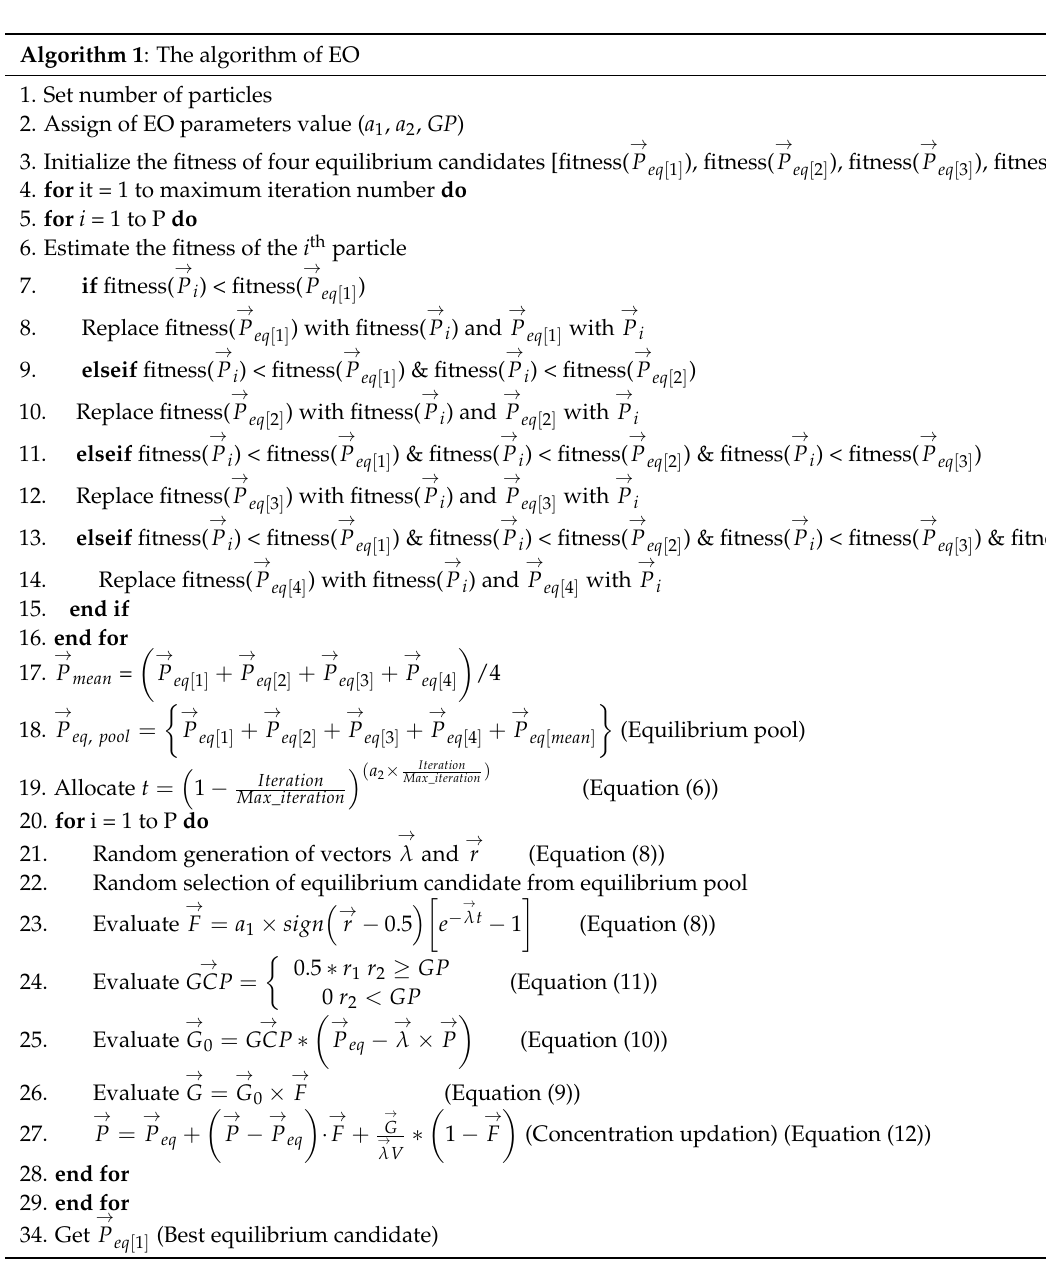
Table 1. Parameters of equilibrium optimizer (EO) for exploration and exploitation. Exploration Exploitation Exploration and